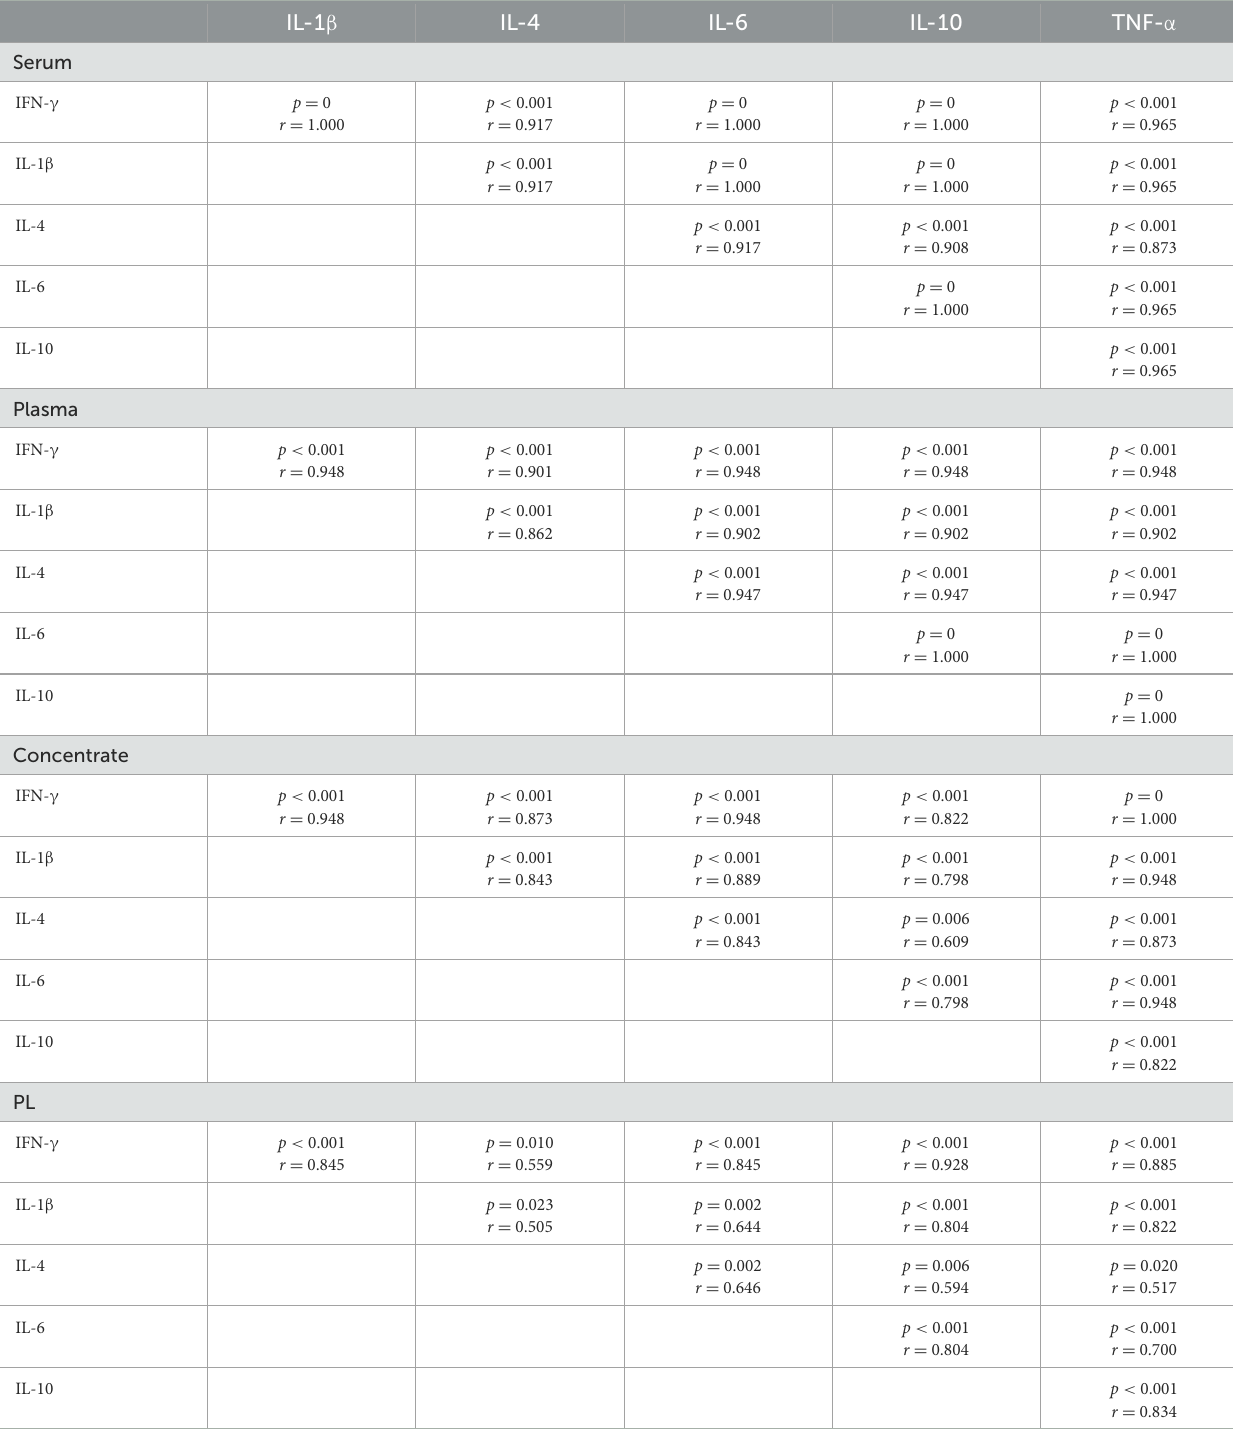
TABLE 3 Correlations between the different cytokines in the respective blood